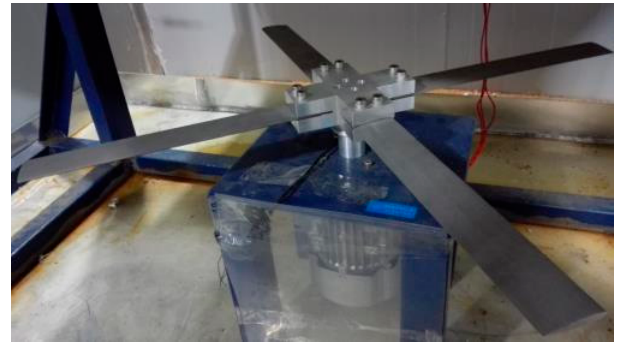
Figure 5. Rotating mechanism with rotor blades installed.